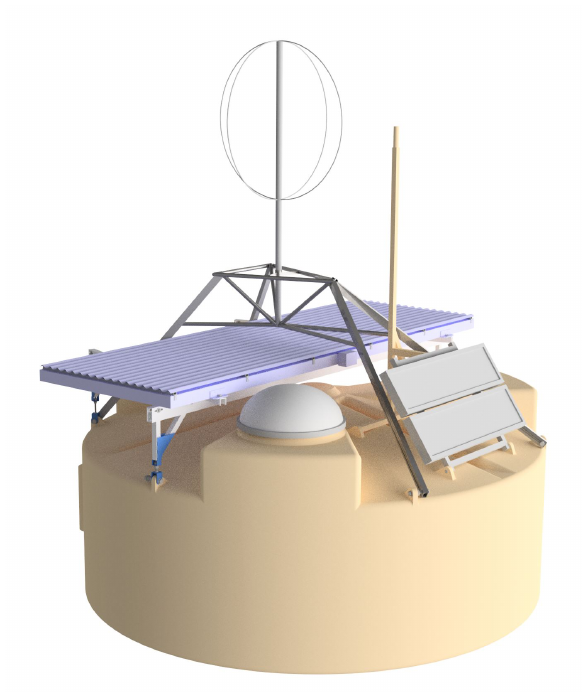
Figure 6. Conceptional illustration of an upgraded station of the Surface Detector array of the Pierre Auger Observatory, com- prised of (from bottom to top) a water-Cherenkov detector, a layer of scintillators, and a radio